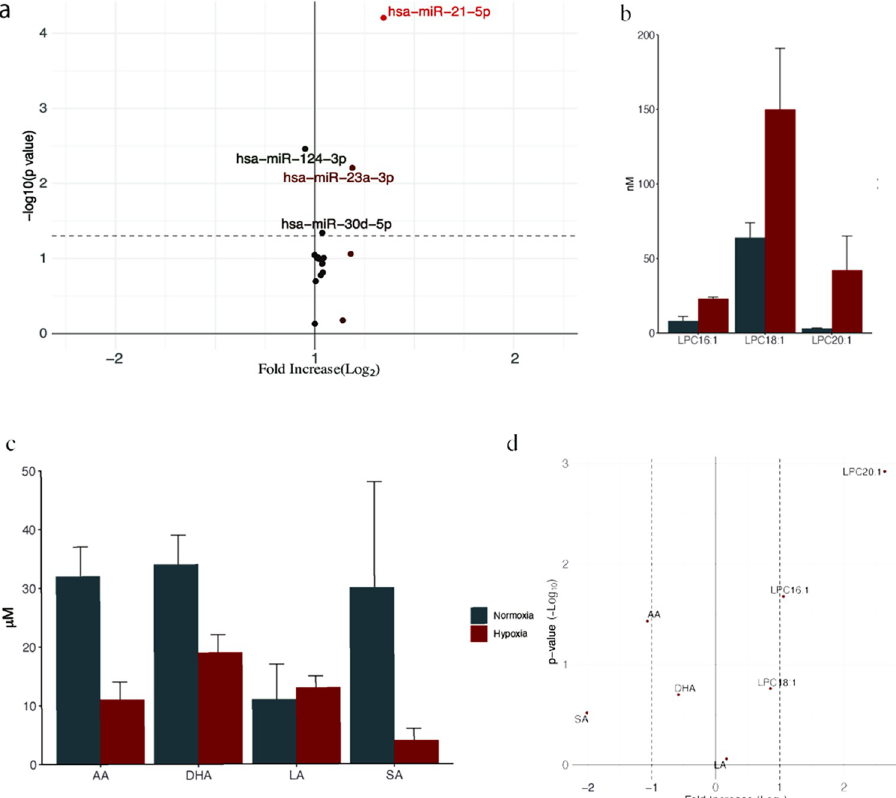
Fig 5. Changes in the expression of miRNAs and lipids after hypoxic stimulation. The expression levels of miRNAs extracted from exosomes were measured using a qPCR array and calculated using the 2 – ΔΔ Ct method (three replicates). The lipid compartment in the exosome was extracted using Bligh and Dyer’s method. Analyses were performed using high-performance liquid chromatography-mass spectrometry. (A) Volcano plot showing miRNA expression plotted using the miScript miRNA PCR Array Data Analysis software. (B, C) Changes in the levels of unsaturated lysophosphatidylcholine ( B ) and free fatty acids ( C ) between the normoxia group (black) and hypoxia group (gray). The results are expressed as mean ± standard deviation of three experiments. (D) Volcano plot representing unsaturated lysophosphatidylcholine and free fatty acids. LPC, lysophosphatidylcholine; FFA, free fatty acid; AA, arachidonic acid; DHA, docosahexaenoic acid; LA, linoleic acid; SA, stearic acid; miRNA, microRNA.